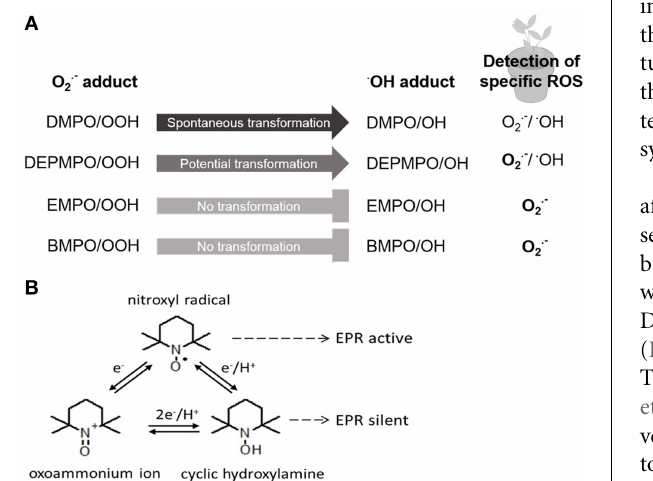
nitroxides are hydrophilic or lipophilic, charged or neutral